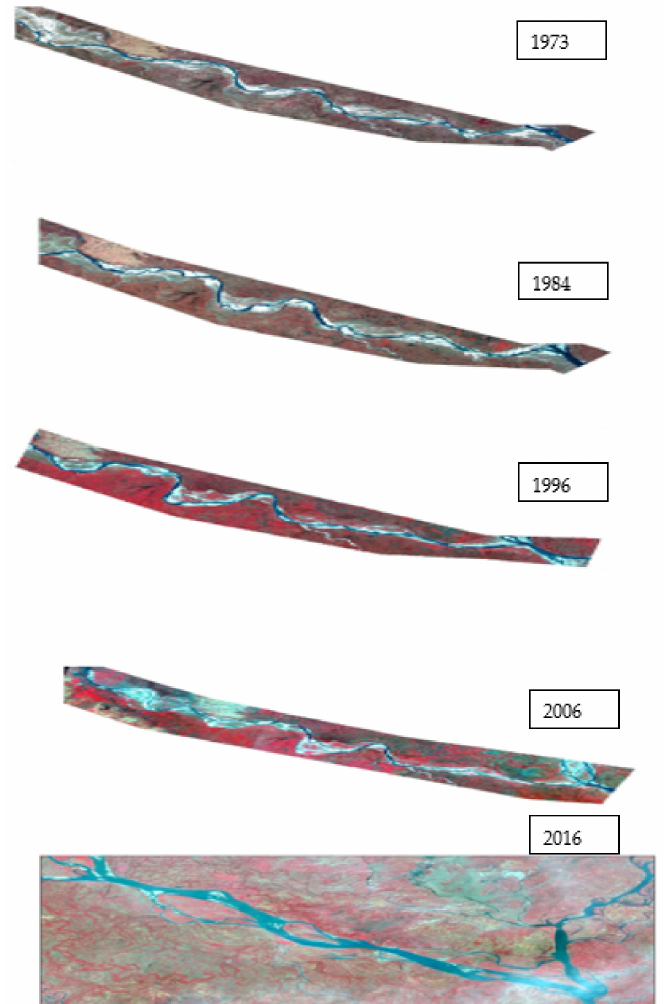
Figure 2. Satellite images that have been used to calculate the sinuosity ratio and braiding index.